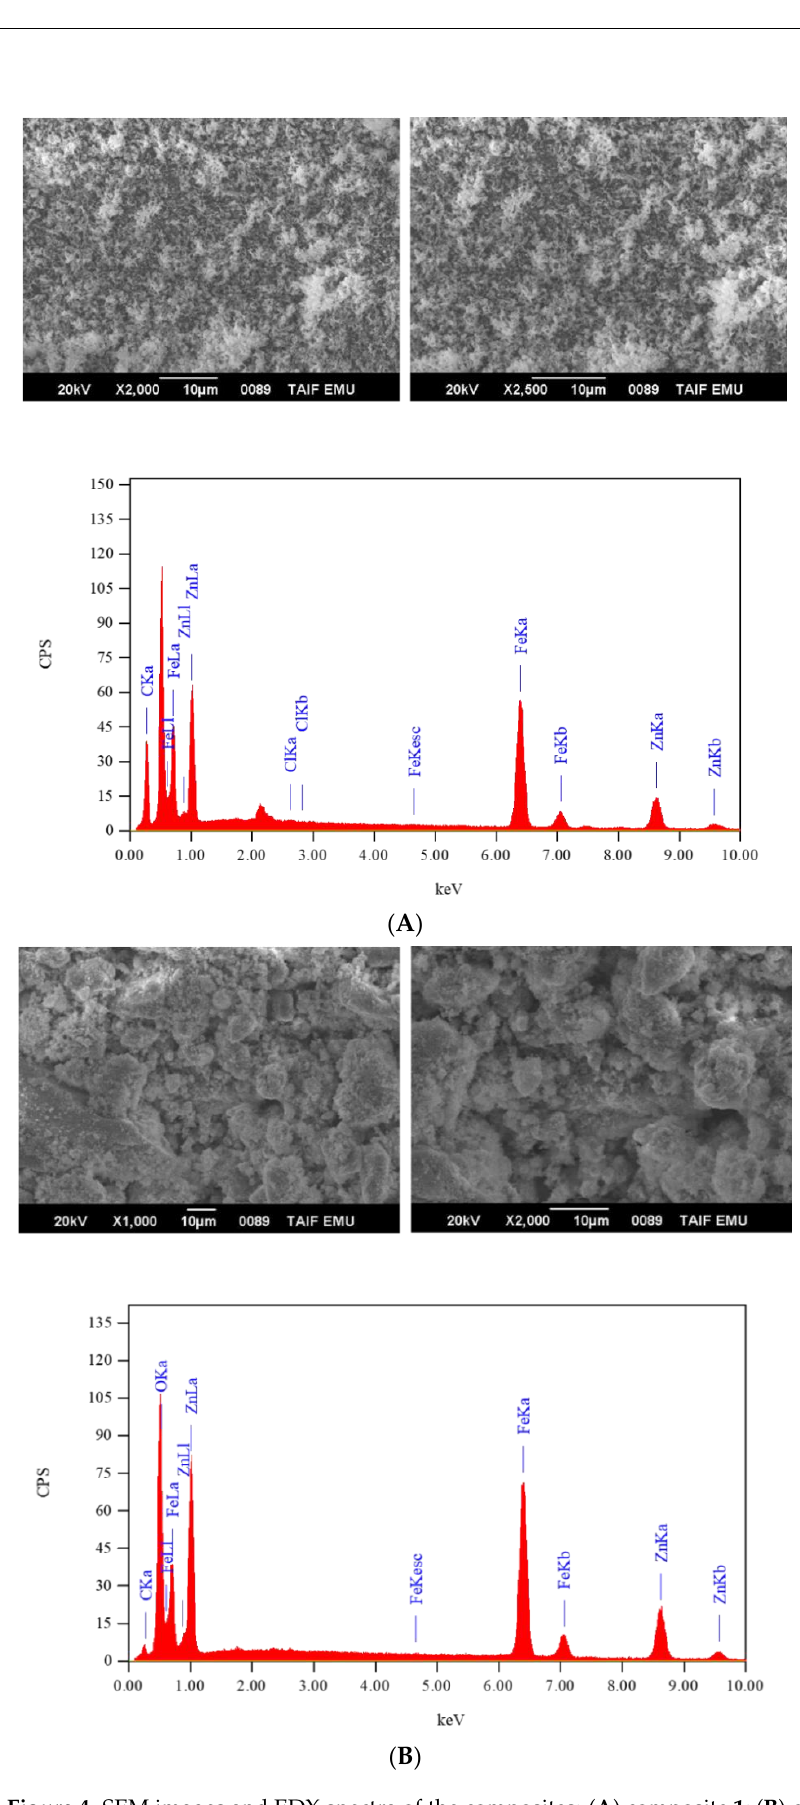
Figure 4. SEM images and EDX spectra of the composites: ( A ) composite 1 ; ( B ) composite 2 .